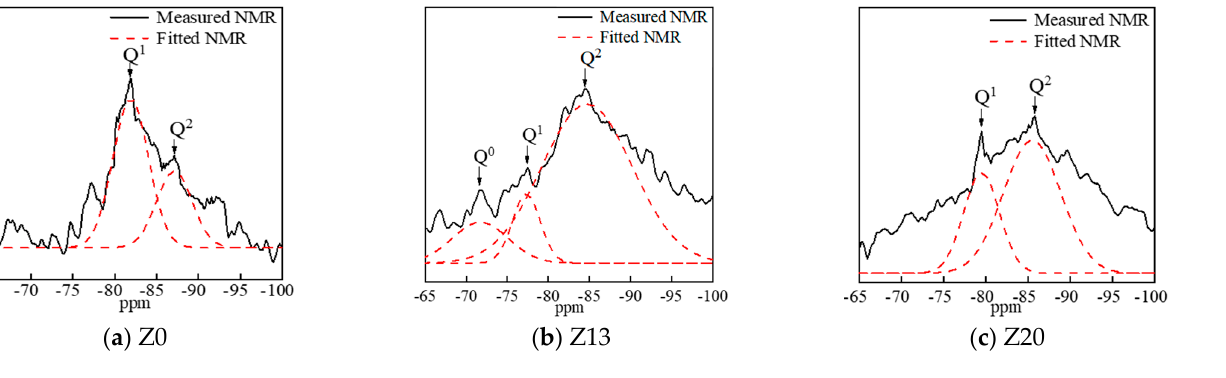
Figure 12. NMR spectra of geopolymers with different ratios.